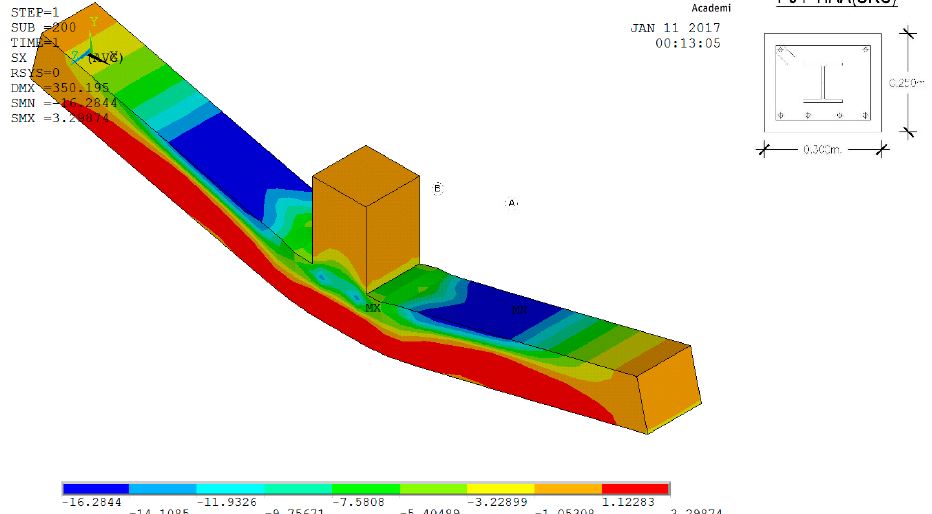
Figure 19. Stresses of concrete in tension and compression for a 350 mm deflection at the center.